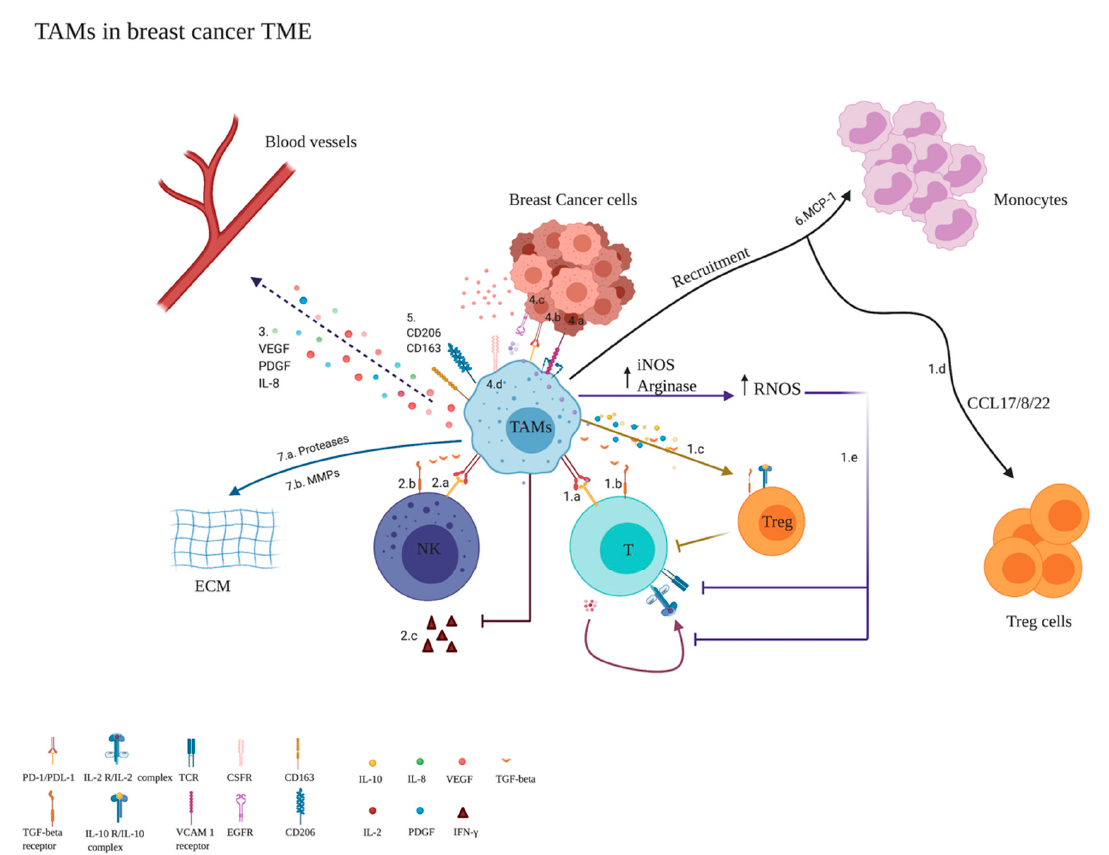
Figure 1. TAMs in the breast cancer TME. 1. The effect of TAMs on T cells: 1.a. TAMs can suppress T-cell proliferation via the programmed death-ligand 1 (PDL-1) [42]. 1.b. TGF-beta affects T-cell function by upregulation of PDL-1 on TAMs [42]. 1.c. Tregs are induced by IL-10, TGF-B, and PDGF-2,